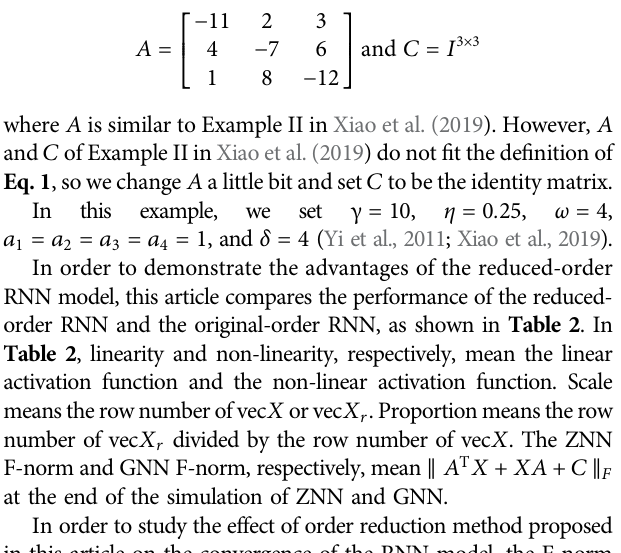
functions. BPAF means the GNN model with the